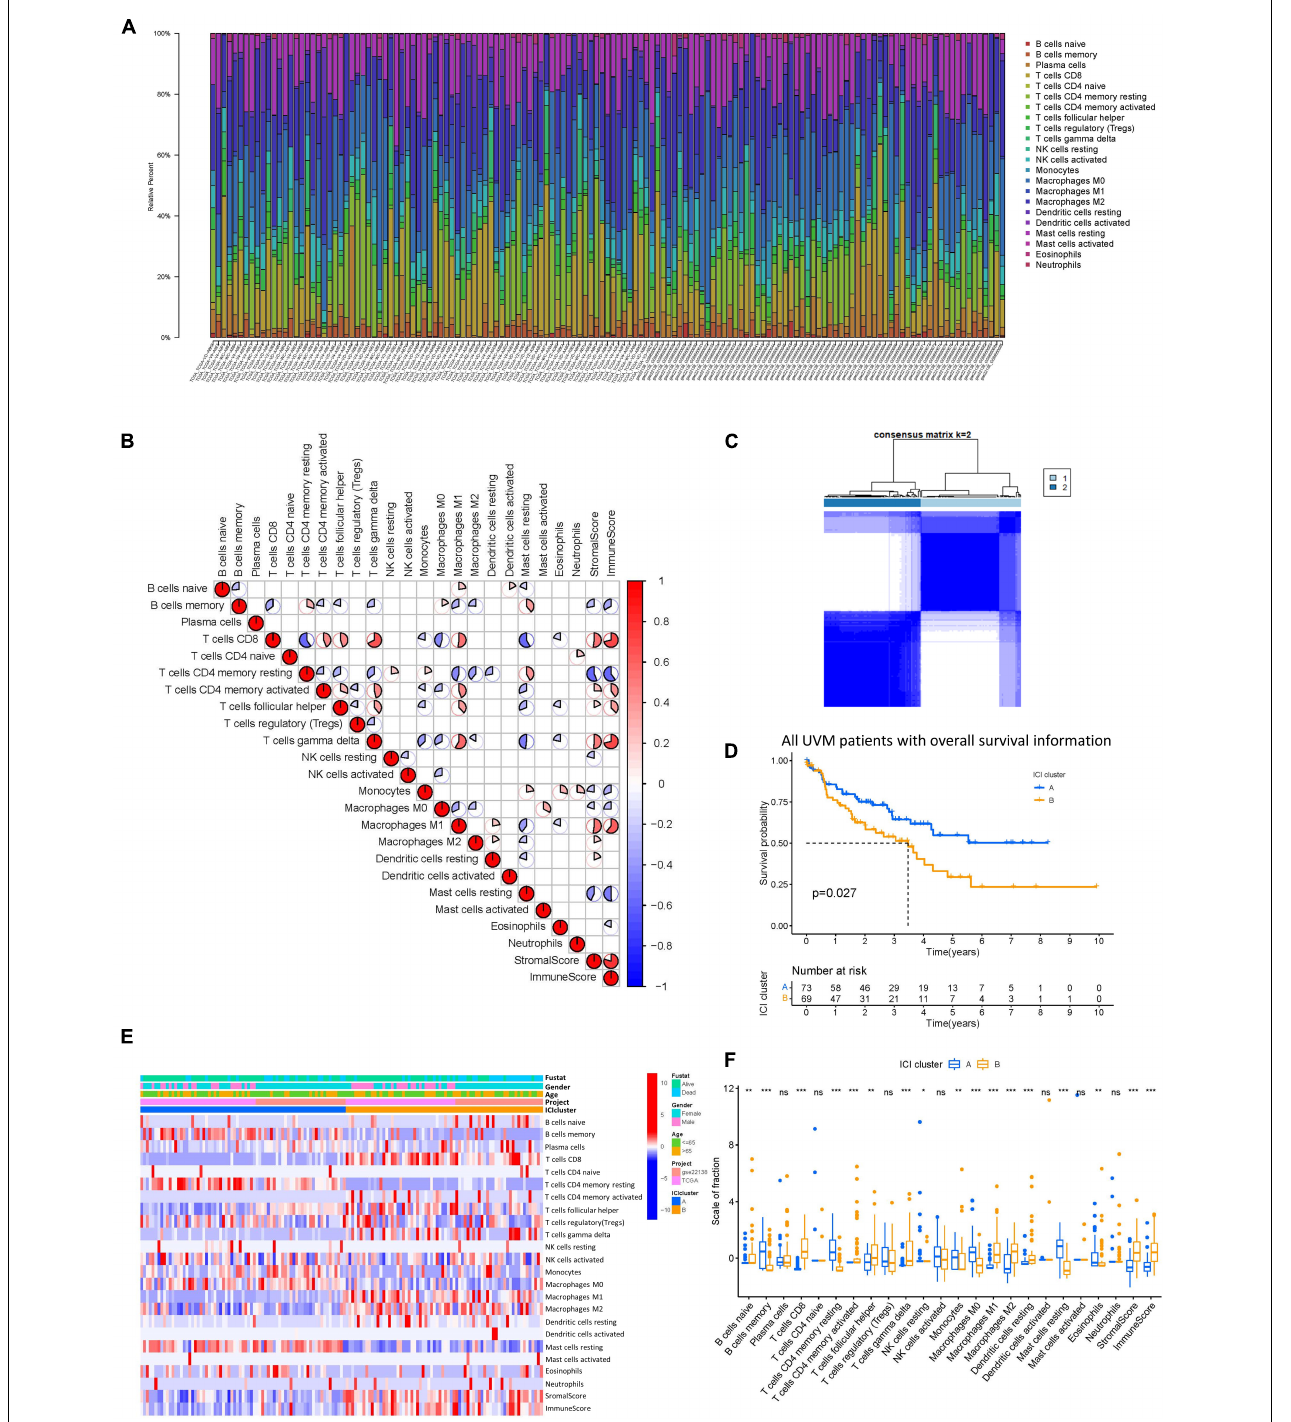
FIGURE 2 | The landscape of ICI in uveal melanoma and the characteristics of ICI subtypes. (A) The bar plot shows the proportion of 22 infiltrating immune cells based on the CIBERSORT algorithm in the TCGA and GEO datasets. (B) The correlation matrix of all 22 infiltrating immune cells. The fraction of immune cells were positively related and are represented in red, whereas others were negatively related and are represented in blue. p < 0.05 was the cut-off. (C) Consensus matrix of all UVM cohorts for k = 2. (D) Kaplan–Meier curves for OS of all UVM patients with ICI classes. Log-rank test shows overall p = 0.027. (E) Unsupervised clustering and hierarchical clustering of ICI in UVM cohorts. Survival status, genders, ages, project, and ICI cluster group are shown as patient annotations. (F) The fraction of tumor-infiltrating immune cells in ICI clusters. We also plotted the immune and stromal scores of three gene clusters. ns, not significant; * p < 0.05; ** p < 0.01; and *** p < 0.001. ICI, immune cell infiltration; UVM, uveal melanoma; OS, overall survival.